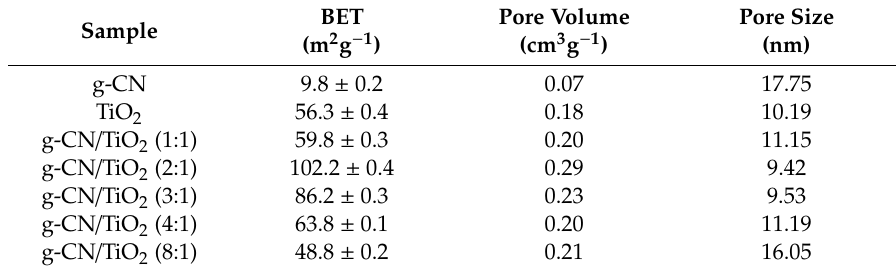
Table 2. Brunauer–Emmett–Teller (BET) speci fi c surface areas, pore volumes and pore sizes of g-CN, TiO 2 , and g-CN/TiO 2 composites. Figure 6. ( a ) Nitrogen adsorption-desorption isotherms of TiO 2 , g-CN, and g-CN/TiO 2 photocatalysts and ( b ) the corresponding pore-size distributions.